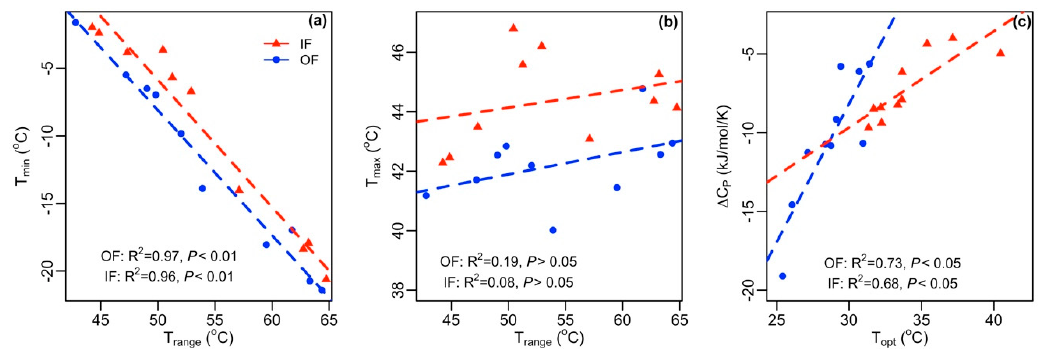
Figure 3. Relationship between temperature ranges and ( a ) minimum temperature for activity; ( b ) maximum temperature for activity; and ( c ) correlation between change in heat capacity associated with the temperature dependence of nitrification ( ∆ C P ‡ ) and optimum temperature predicted by the MMRT model.